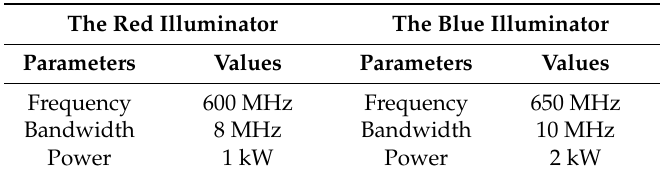
Table 1. The Basic Parameters of Two Frequency Networks. Table 2. The Other System Parameters of Two Frequency Networks.